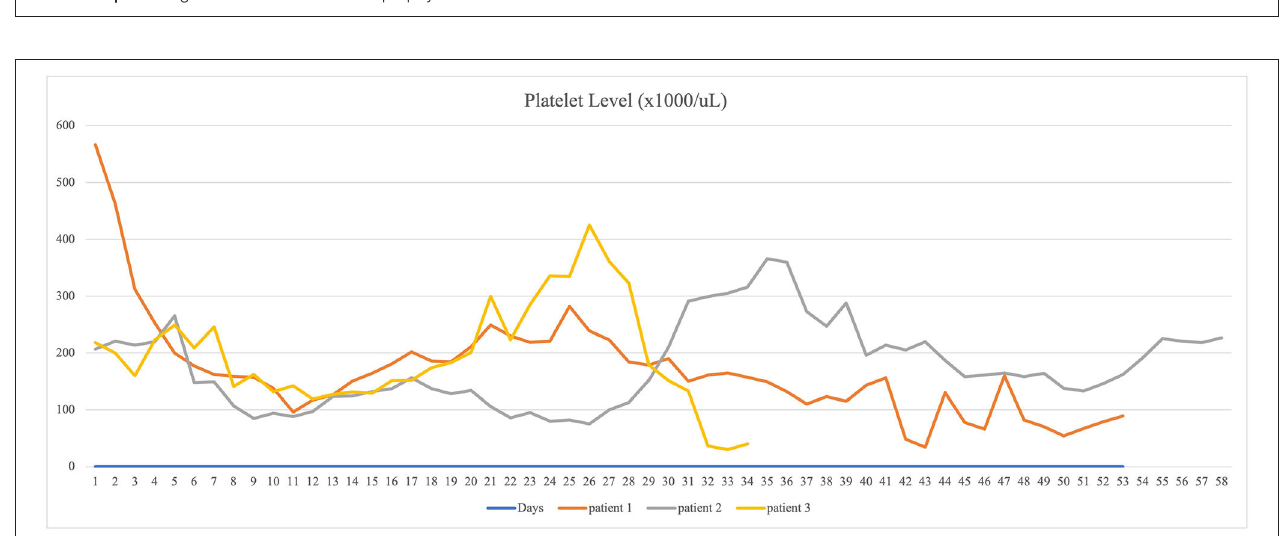
FIGURE 2 | The course of platelet counts of the three ECMO-managed COVID-19